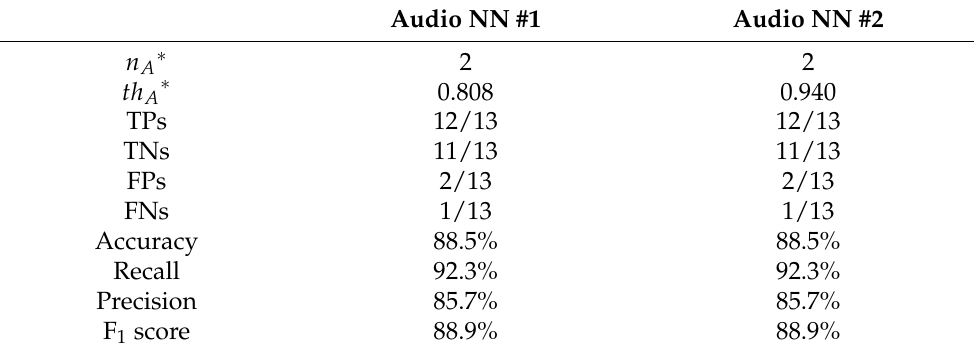
Table 5. Test video results for audio NN model